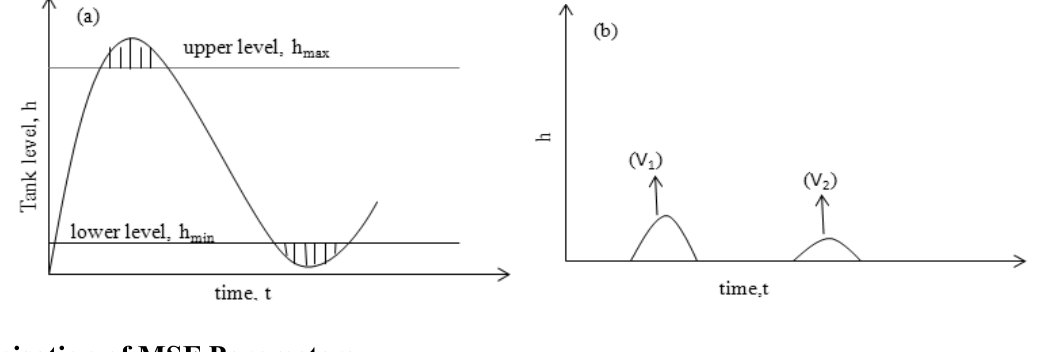
Figure 5. ( a ) Tank level profile and ( b ) tank level violations during the MSF